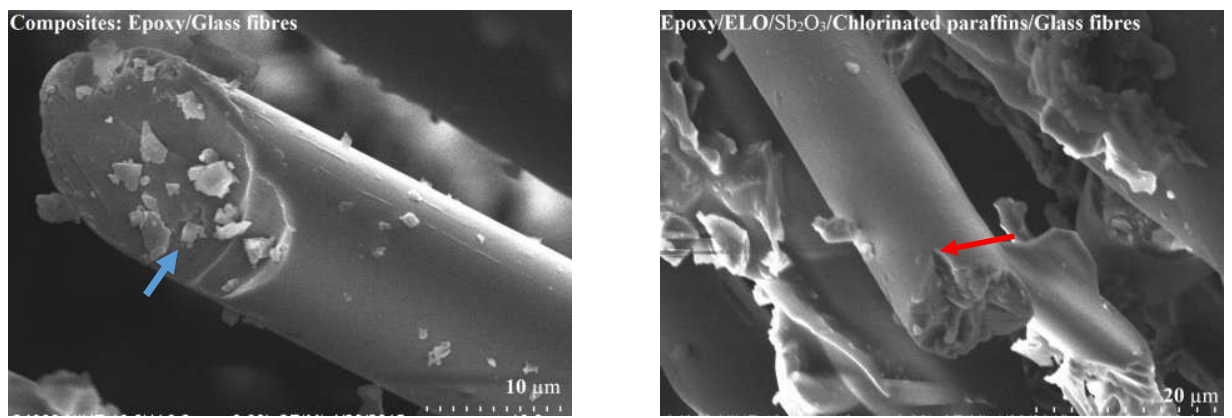
FIG. 10. FE-SEM MICROGRAPHS OF THE SAMPLES: COMPOSITES EPOXY/GLASS FIBRES AND COMPOSITES EPOXY/ELO/CHLORINATED PARAFFINS/GLASS